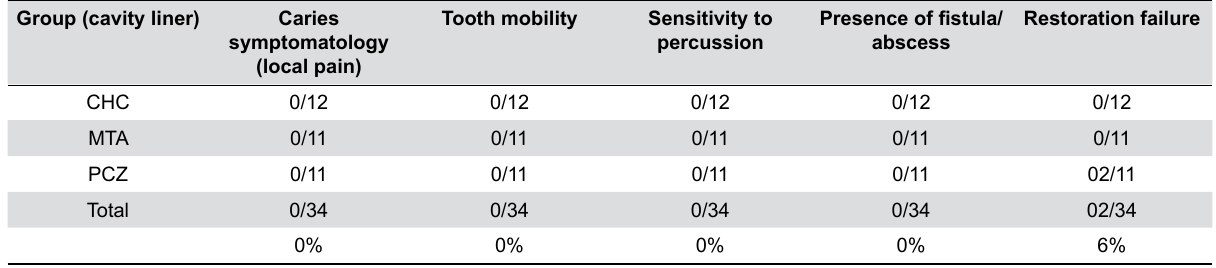
Table 1- Clinical assessment of the use of different cavity liners in the selective caries removal from primary teeth, at 12-month follow-up